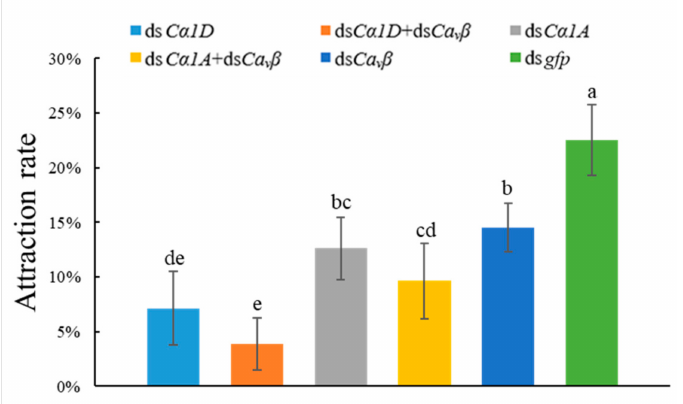
Figure 7. Silencing of Ca v β or HVA Ca v α 1 and co-silencing of Ca v β and HVA Ca v α 1 caused defects in the chemotaxis of D. destructor toward sweet potato slices. Nematodes that were treated with gfp dsRNA were used as controls. Different lowercase letters indicate a significant difference at the level of p < 0.05, as tested by Duncan’s new complex difference